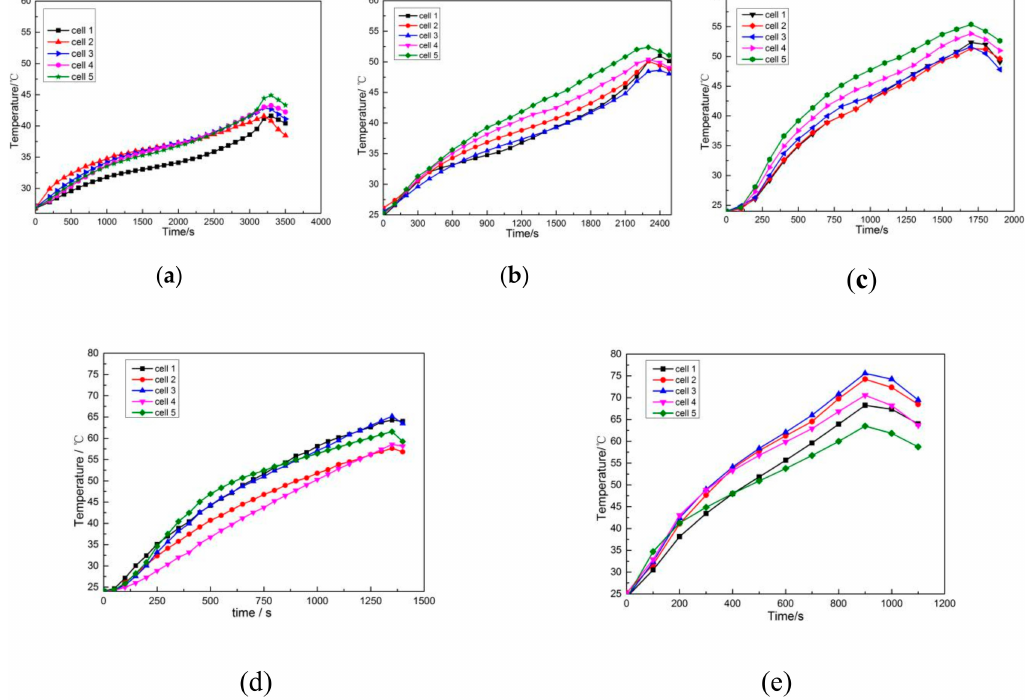
Figure 5. Temperature curve under di ff erent discharge rates and natural heat dissipation at 25 ◦ C ambient temperature: ( a )1C; ( b ) 1.5C; ( c ) 2C; ( d ) 2.5C; ( e )